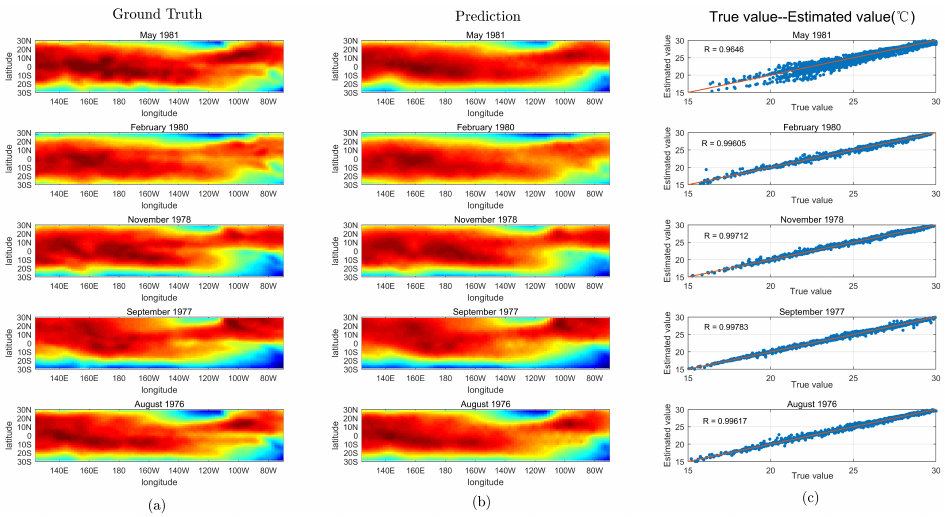
Figure 8. Temperature images from the PST data set. ( a ) Ground truth; ( b ) Estimates of the resampled points using our algorithm; and ( c ) Predicted against resampled points for all real